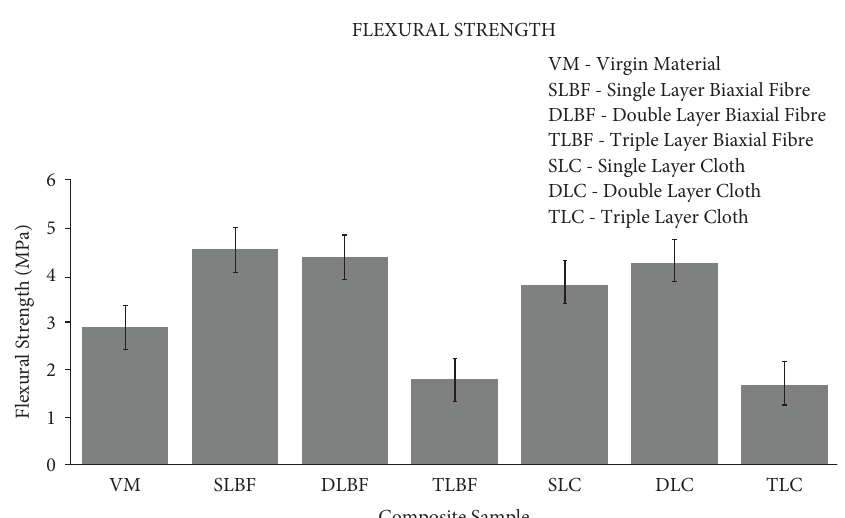
Figure 14: Comparative study of the fexural strength of SFs and SCs reinforced vinyl ester composites.